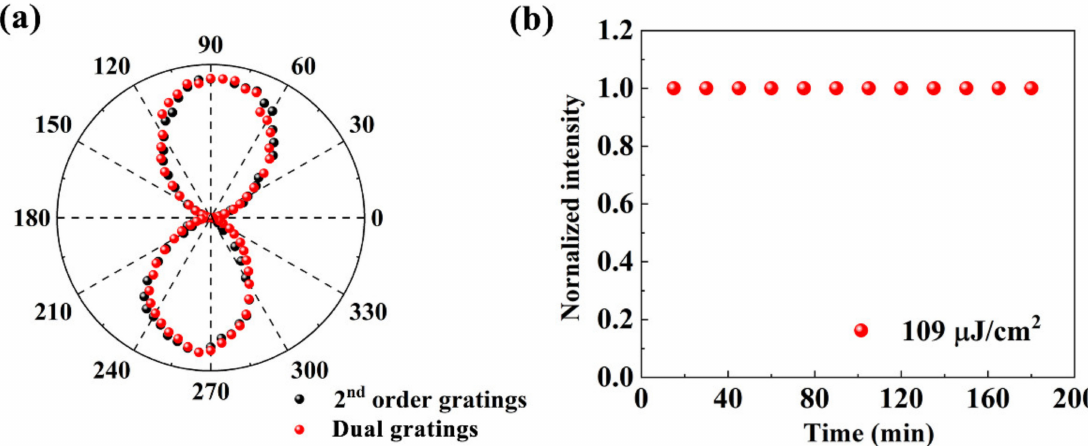
Figure 6. ( a ) Characterization of the polarizations of the second-order DFB laser and the dual-grating laser. ( b ) Stability characterization of the dual-grating